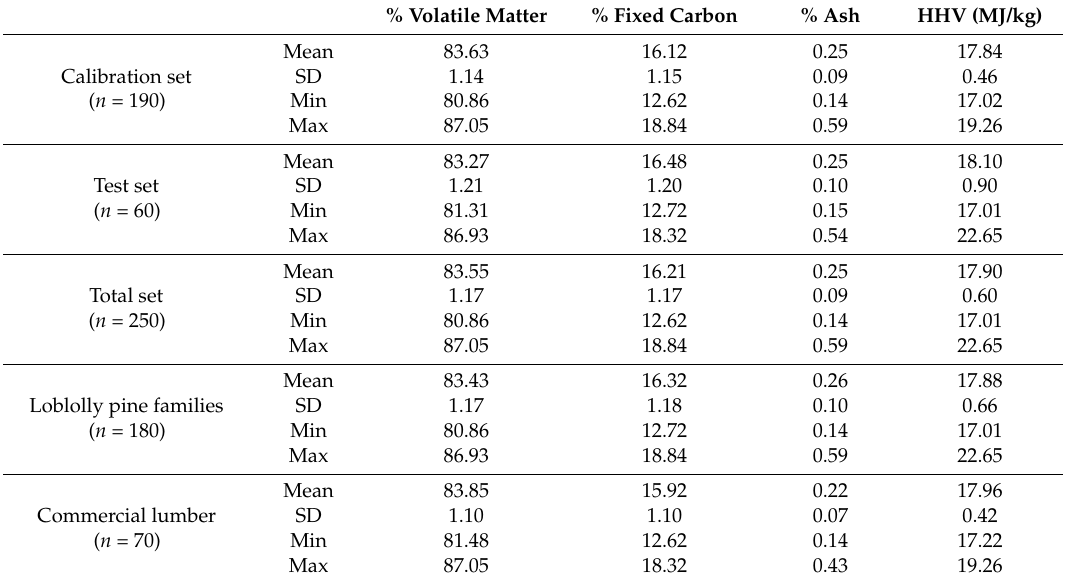
Table 2. Descriptive statistics of the proximate composition and energy content of southern pine